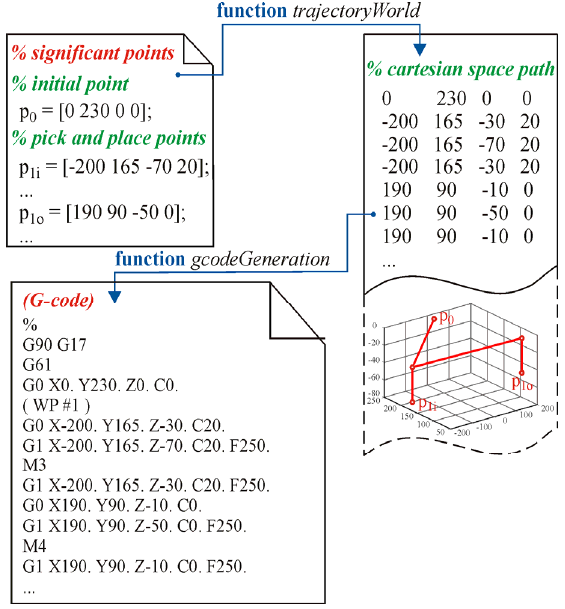
Figure 6. Developed programming